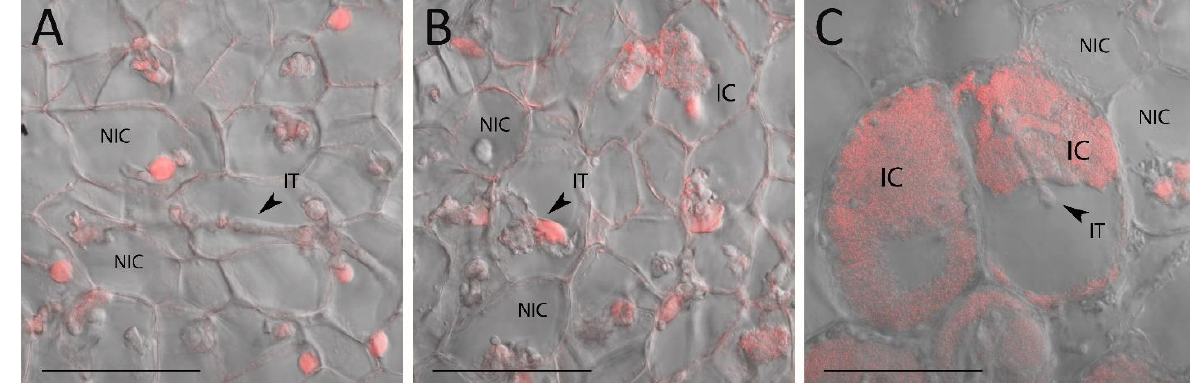
Figure 2. Images of nodule sections of sym33-3 mutant plants non-treated ( A ) or treated with increasing concentrations of cytokinin 6- BAP such as 5 μM ( B ) and 10 μM ( C ) were obtained using a confocal microscope. Bacteria and plant cell nuclei were stained using propidium iodide. Infected (IC) and non-infected cells (NIC), the infection threads (IT) are marked in the figure. The images are 63X magnified and scaled at 50 µm.